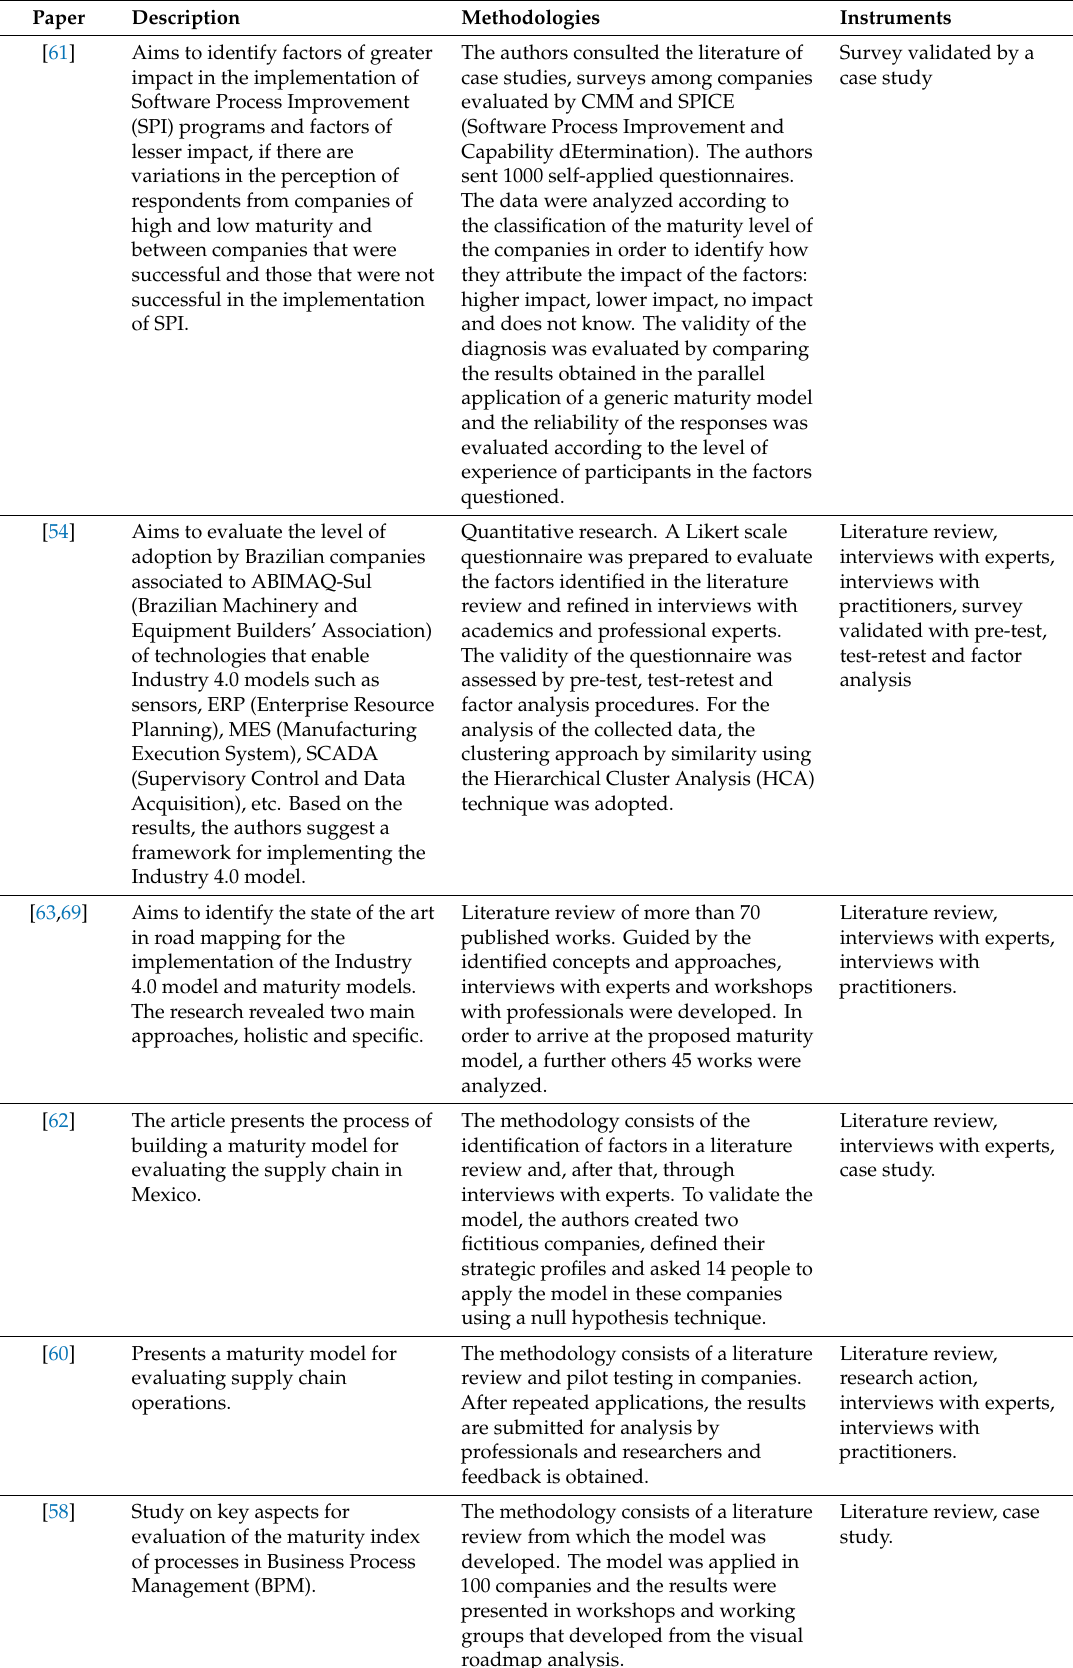
Table 4. Methodologies for the construction of maturity models identified in the literature